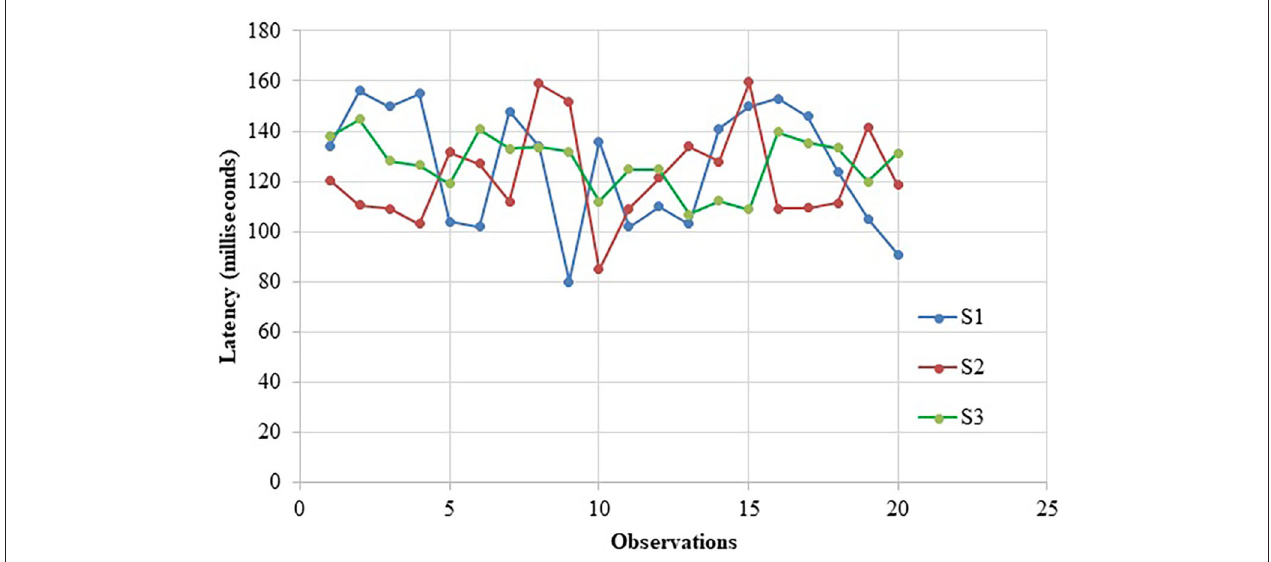
FIGURE 11 | Latency Test results in a chart for three test